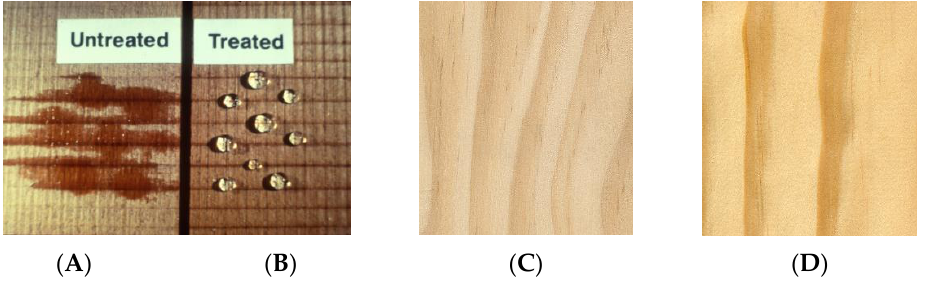
Figure 10. Wood surface before ( A ) and after ( B ) plasma treatment, southern yellow pine before ( C ) and after plasma treatment ( D ).